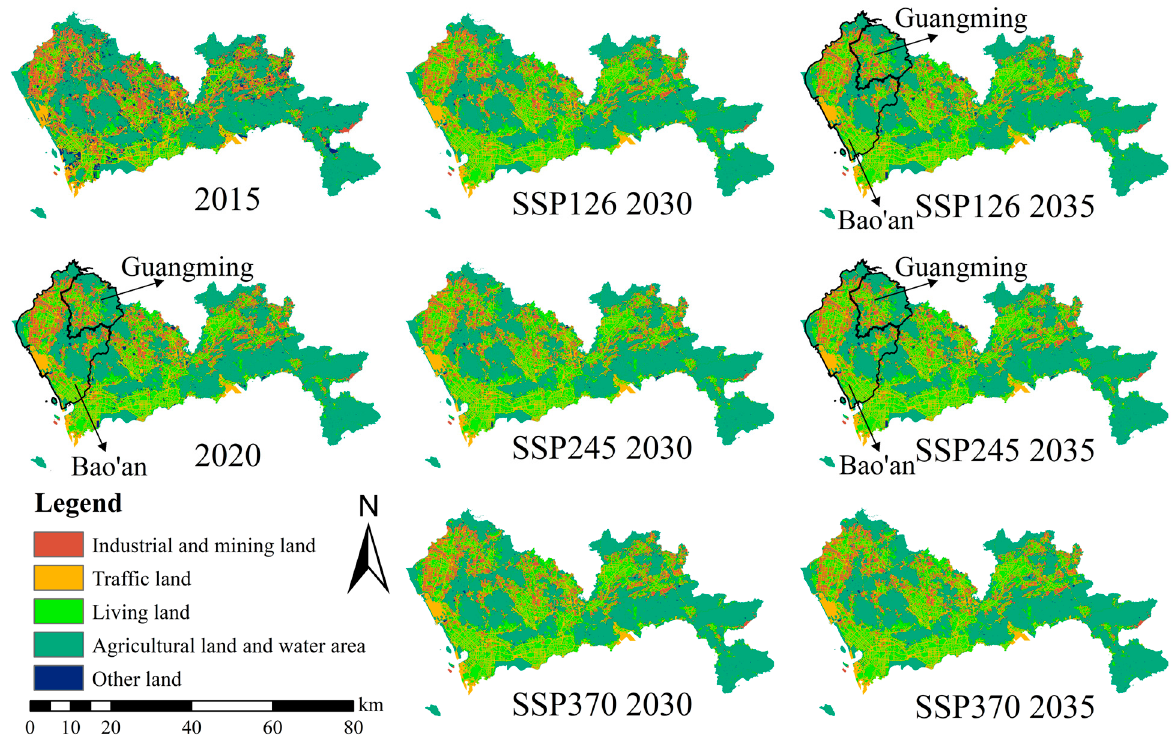
Figure 5. Future land use patterns under SSP-RCP scenarios in Shenzhen.